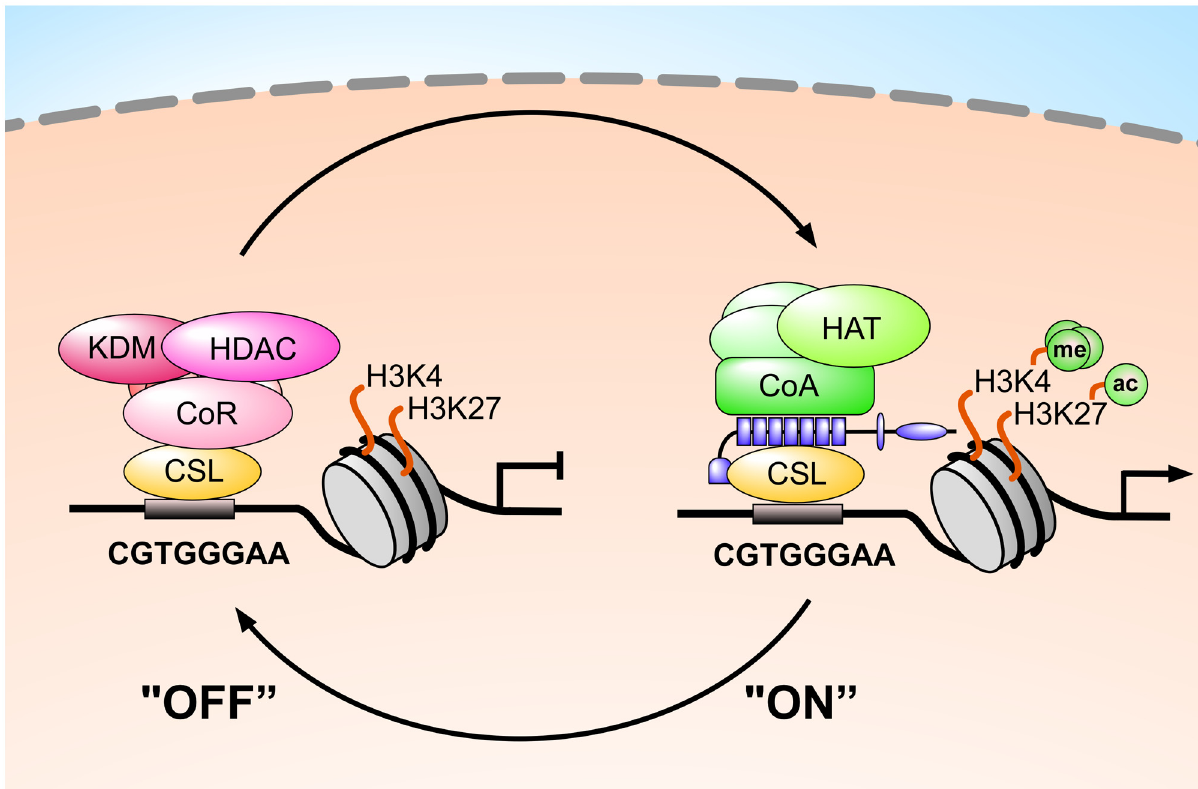
Fig 1. CSL functions as a molecular switch by binding either to corepressors or coactivators: Without an active Notch signal ( “ OFF ” ), CSL recruits corepressor complexes. H3K4 Demethylase (KDM) and HDAC activity erase the active chromatin marks H3K4me3 and H3K27ac, establishing a repressed chromatin state (left). After nuclear translocation, NICD (blue) interacts with CSL, recruiting a coactivator complex (right). H3K4-methyltransferase and histone acetyltransferase (HAT) activity establish the active chromatin marks H3K4me3 and H3K27ac, setting the chromatin in a transcriptional active state ( “ ON ” ).